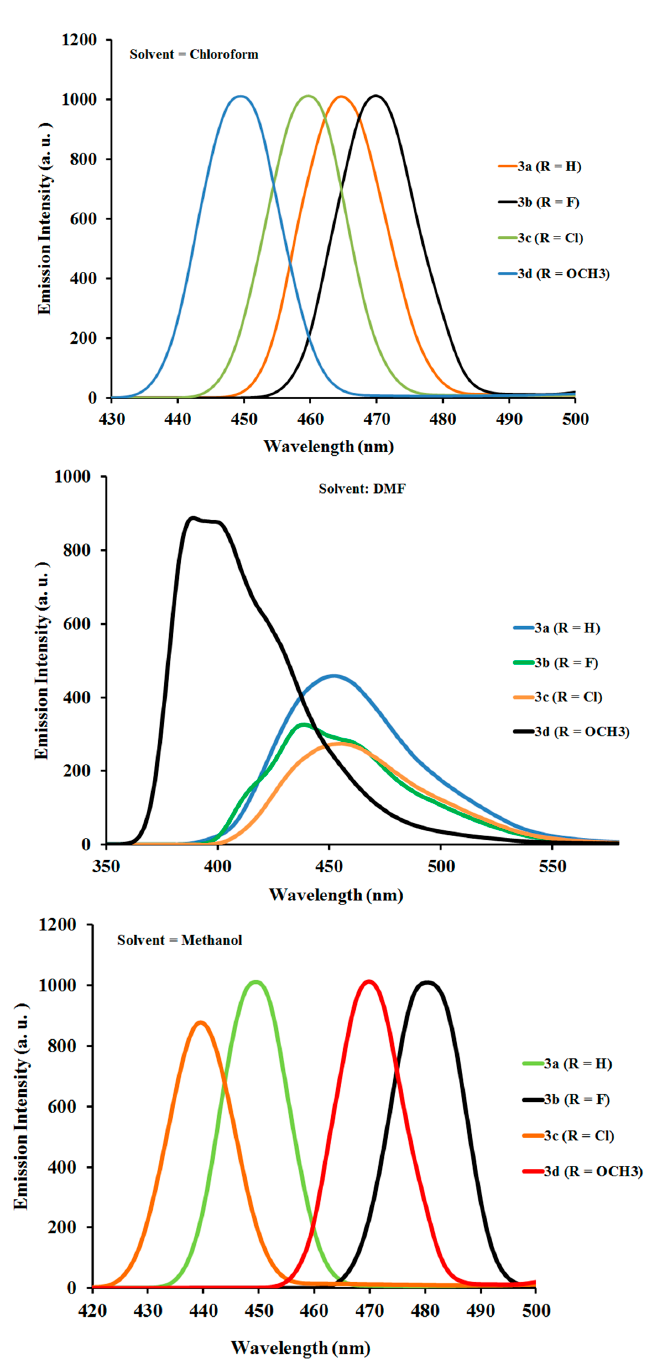
Figure 4. Fluorescence emission spectra of 3a – d (concentration 2.0 × 10 − 7 mol/L) at RT.